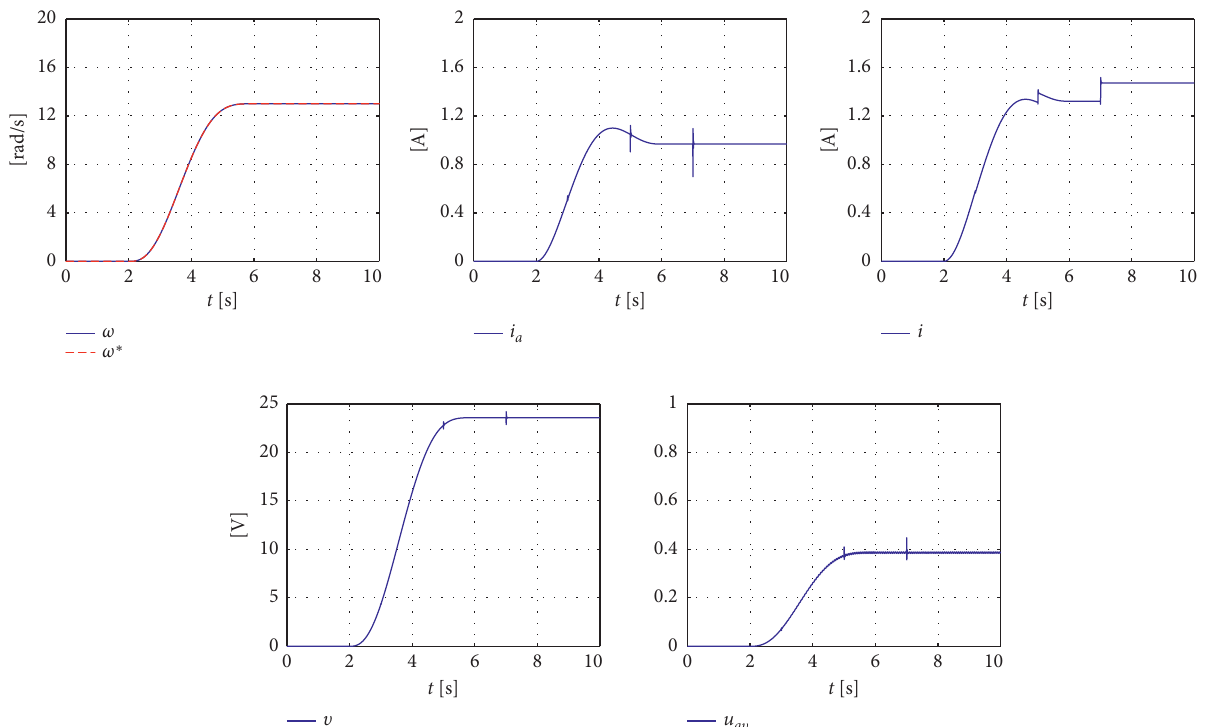
Figure 6: Time-response of the DC/DC Buck converter-DC motor system when using the waveform (equation (18)) and abrupt variations (equation (21)) in R .